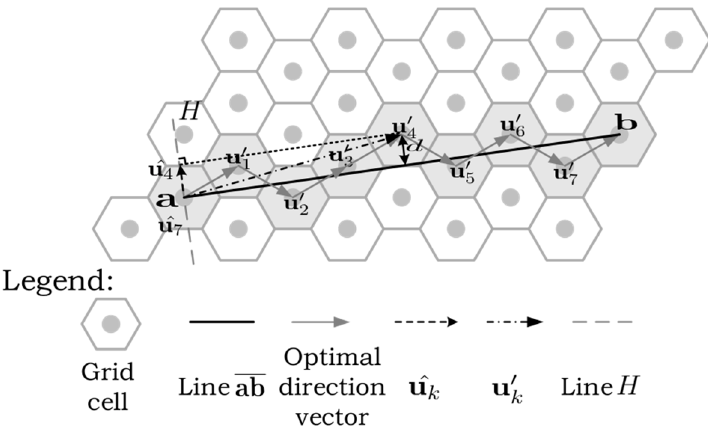
Figure 8. Schematic of the projection relationship.